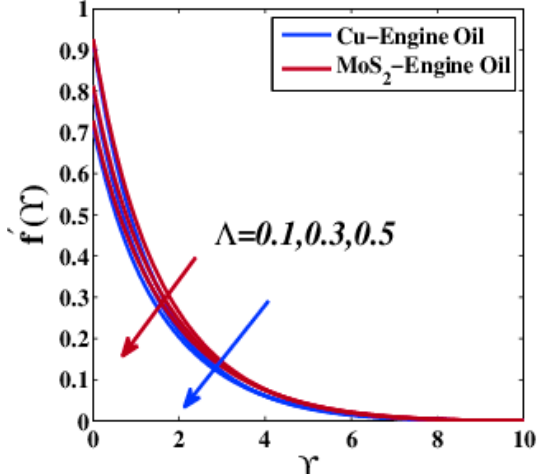
Figure 15. Entropy generation variation N G under the influence of φ .